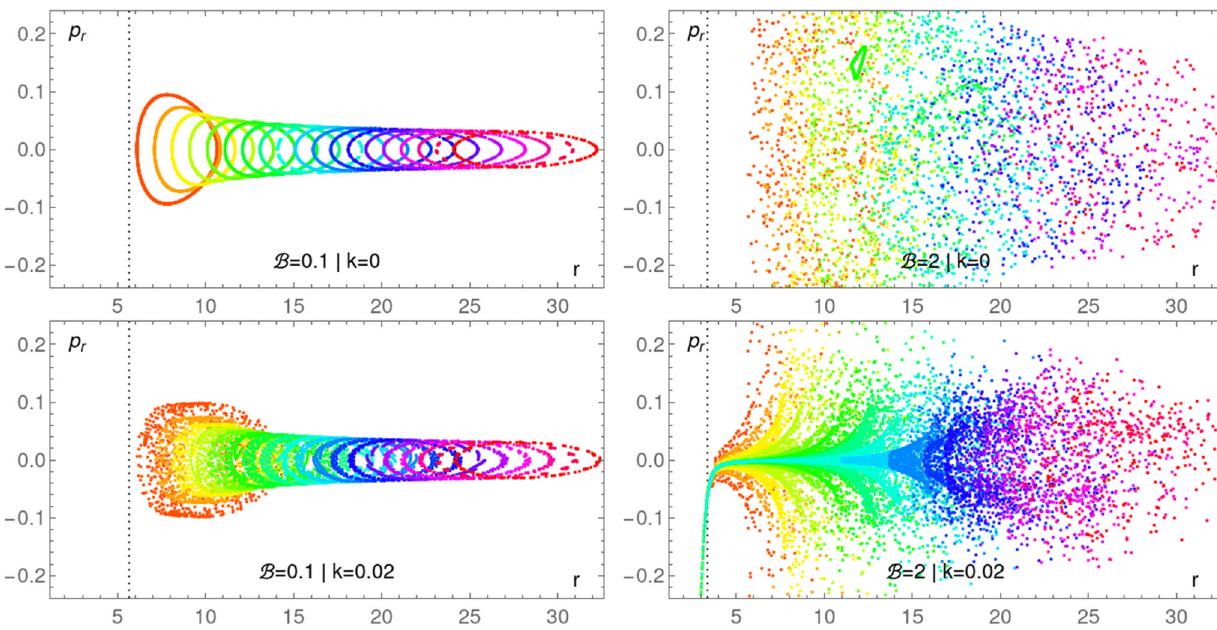
positions. In the two lower plots, the RR is included and we can see that some trajectories are attracted to the BH. All radiating particle trajec- tories may eventually end up in BH, however for small B and k , or if the orbit is far away from the BH, the accretion takes much longer